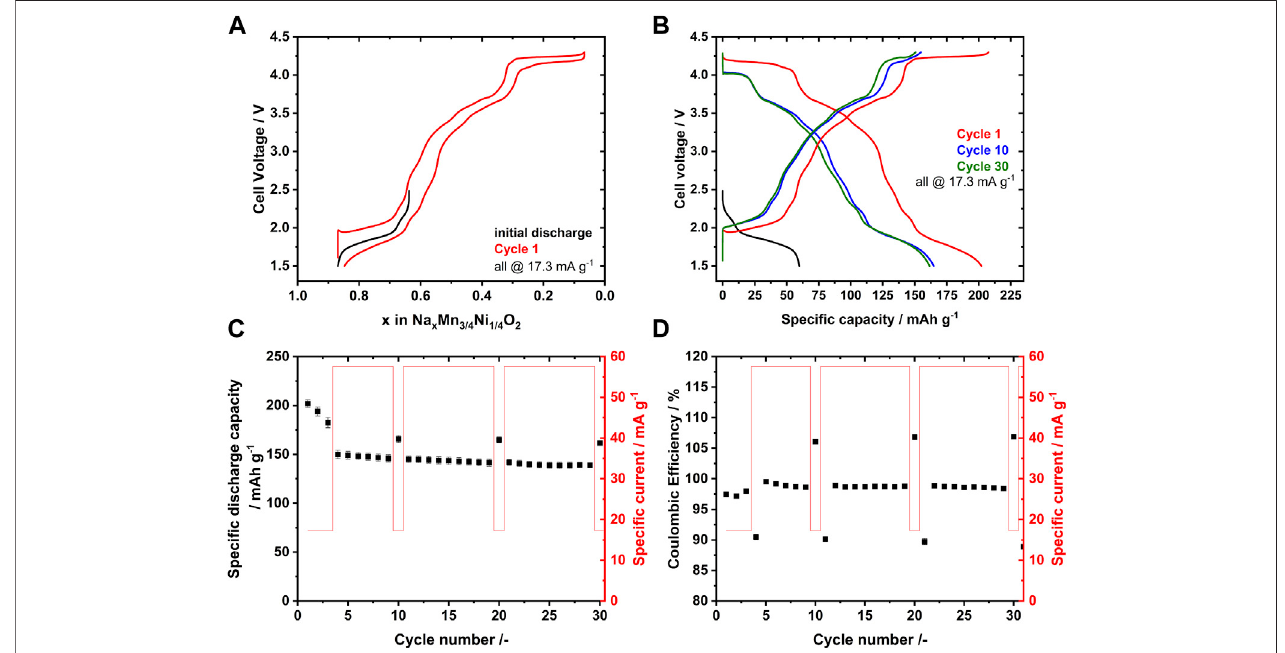
FIGURE 8 | Electrochemical characterization of phase pure P2-Na 0.64 Mn 3/4 Ni 1/4 O 2 in sodium half-cells. (A) potential pro fi le of initial discharge and cycle 1 (B) charge and discharge potentials of cycle 1, cycle 10 and cycle 30 (C) speci fi c discharge capacity of the fi rst 30 cycles (D) coulombic ef fi ciency of the fi rst 30 cycles. In (C,D) points represent an average value of three cycles. The standard deviation of these cells is presented as error bars. Cycles 1, 2, 3, 10, 20, 30 are performed at 17.3 mA g − 1 (C/10), all other cycles are performed at 57.8 mA g − 1